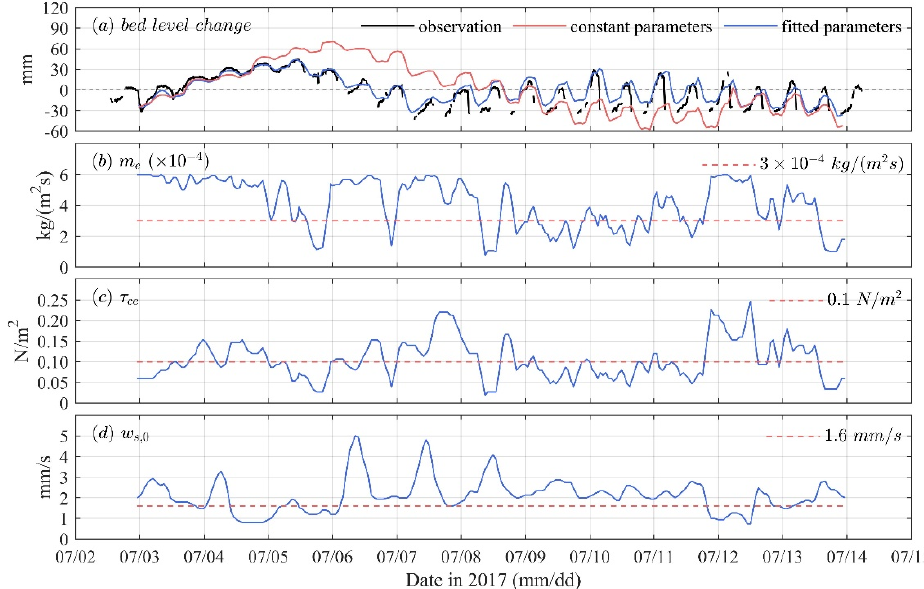
Figure 7. ( a ) Comparison between measured RBL (ADV-1) and simulated RBL using constant (red) and time-varying (blue) parameters, ( b – d ) constant and time-varying m e , τ ce , and w s ,0 . Parameters presented here are smoothed using a three-hour moving average and the RBL (blue) is computed using the smoothed parameters.